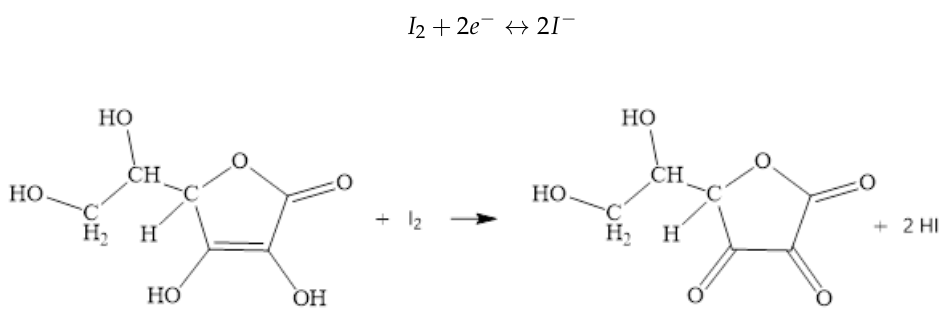
Figure 3. The reaction between vitamin C and iodine.